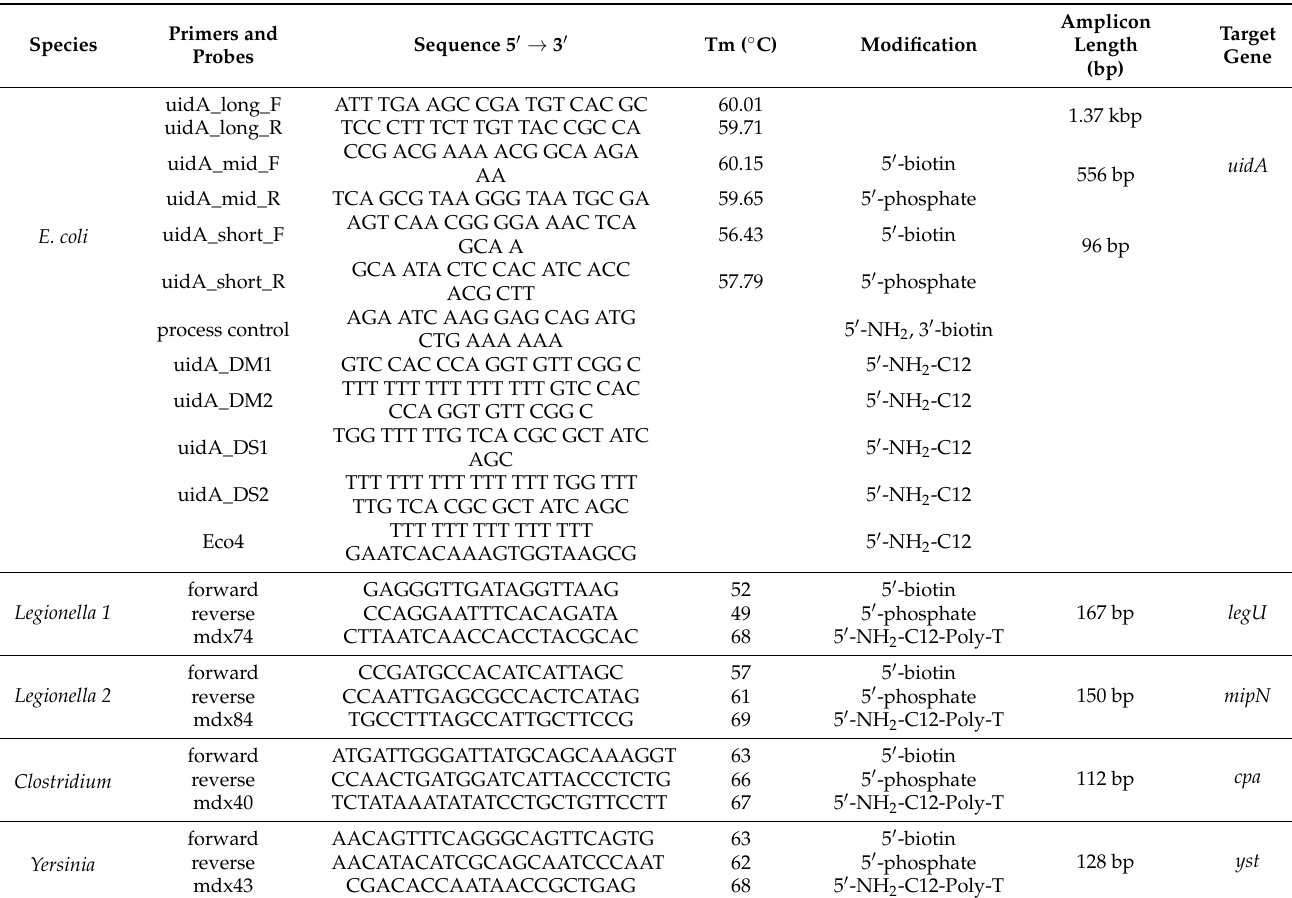
Table 1. Primers and capture